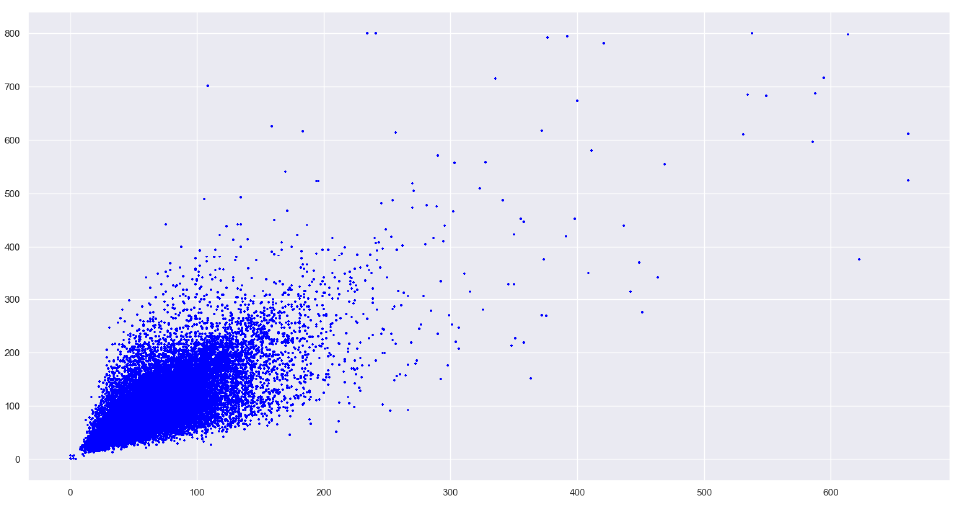
Figure 7. Size distribution of labels in URPC2018 dataset.